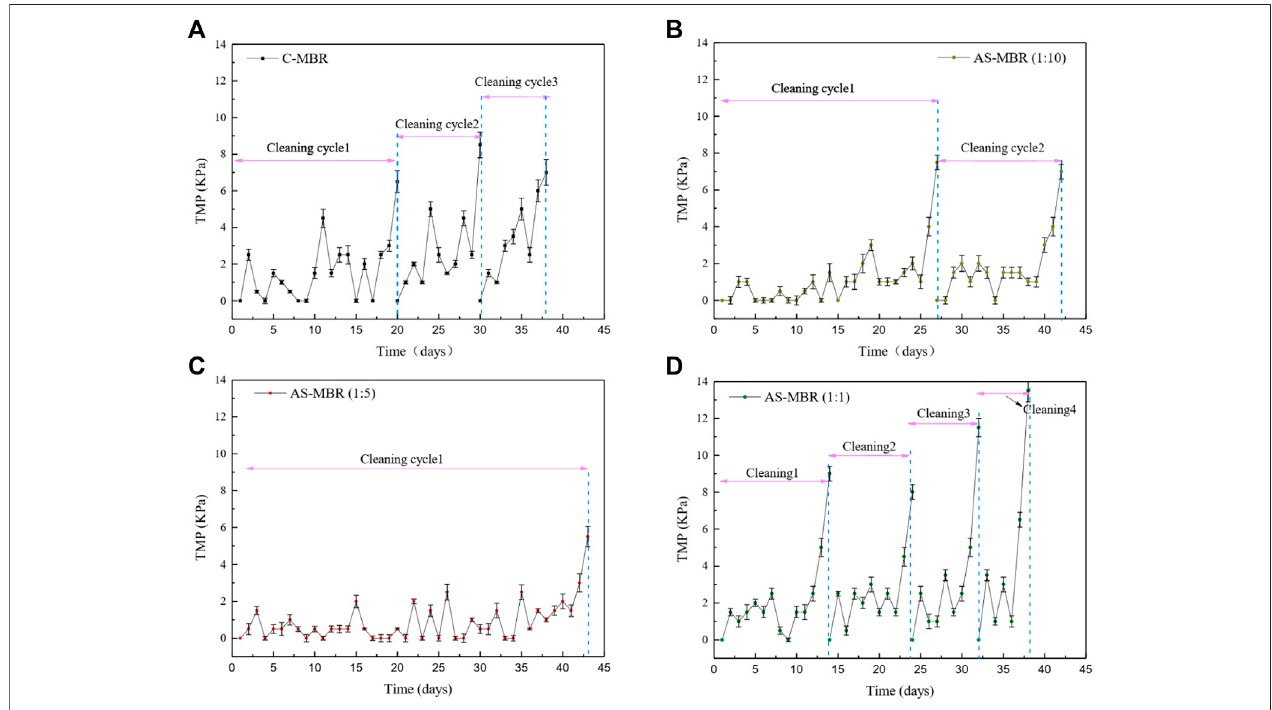
FIGURE2| Pro fi lesofdTMP/dTinthefourreactorswithdifferentalgae/bacteriainoculationratios: (A) systemwithoutalgae, (B) 1:10ratioofalgaeandbacteria, (C) 1:5 ratio of algae and bacteria, and (D) 1:1 ratio of algae and bacteria.